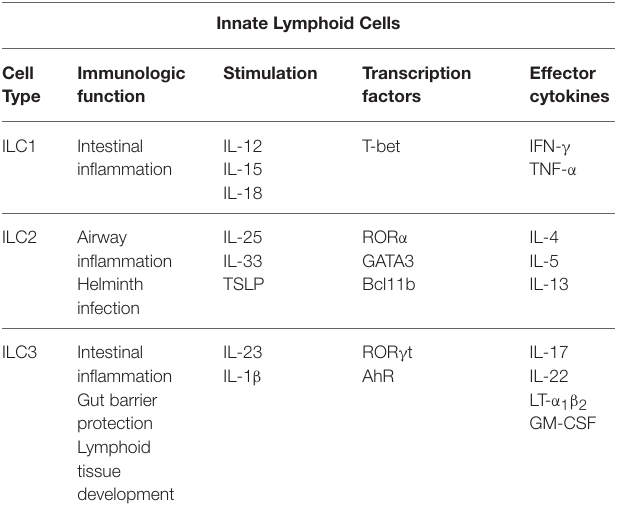
TABLE 1 | Description of the different types of innate lymphoid cells